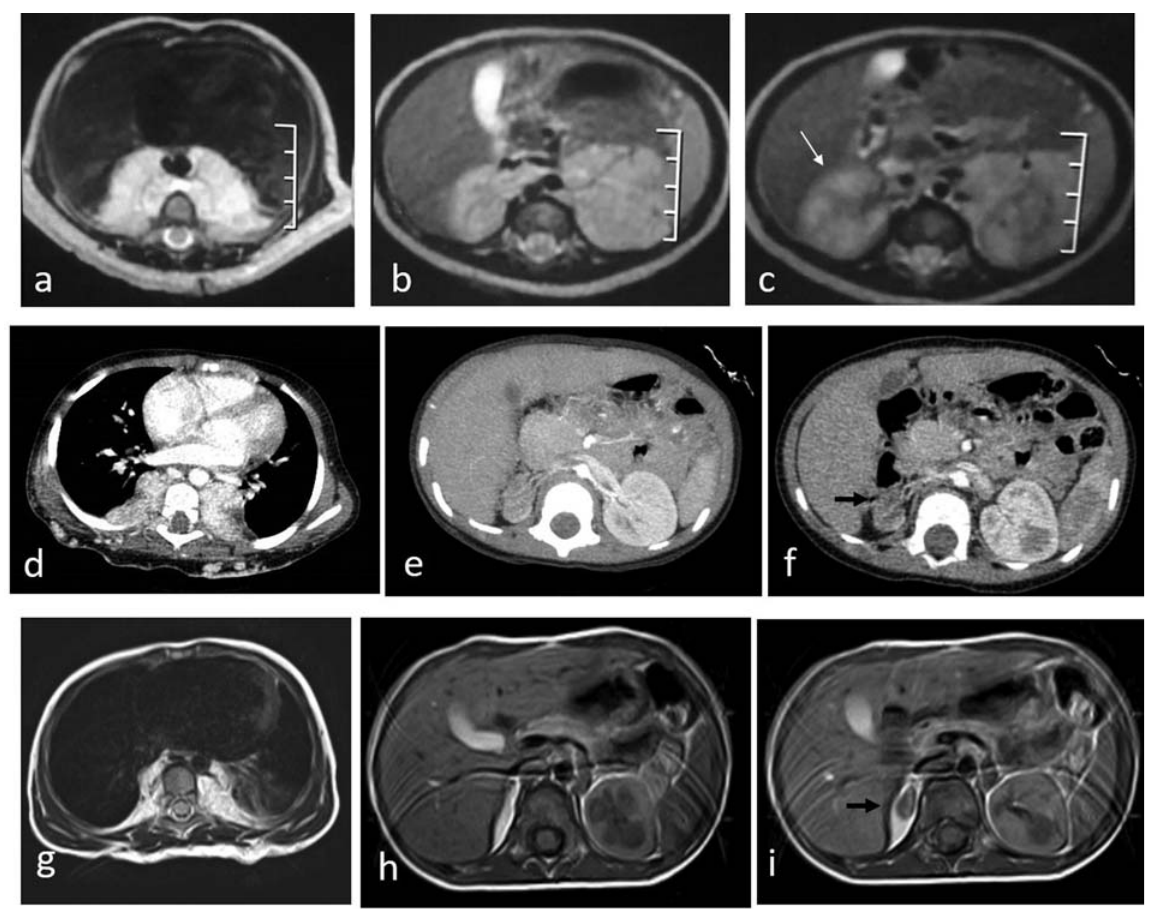
Fig. 2 First case of a boy with cutaneous back and posteriormediastinal hemangiomas. ( a – c ) Magnetic resonance imaging (MRI) study performedat the age of3months beforetreatment.The mediastinal masswasseenin( a ) as bilateralsymmetricalmass, pre- andparavertebralinlocation, compressingthe adjacent posterior aspects of both lung lobes and encasing adjacent parts of the aorta. The retroperitoneal component was seen in ( b ) and ( c ) in the suprarenalregionpartiallyencasingtheupperpoleofbothkidneys.( d – f )Computedtomography(CT)studyperformedatpresentationtoourclinic(ageof2 years).Notetheregressionof the paravertebralmasses;however,therewasatrophyof therightkidney( blackarrow in f ),whereasit waspresentinthe fi rst study at the age of 3 months ( white arrow in c ). ( g – i ) MRI study performed at follow-up after treatment (at the age of 3 years) demonstrating marked regression of the deep hemangiomatous lesions (posterior mediastinal and retroperitoneal). Note atrophy of the right kidney ( black arrow ).